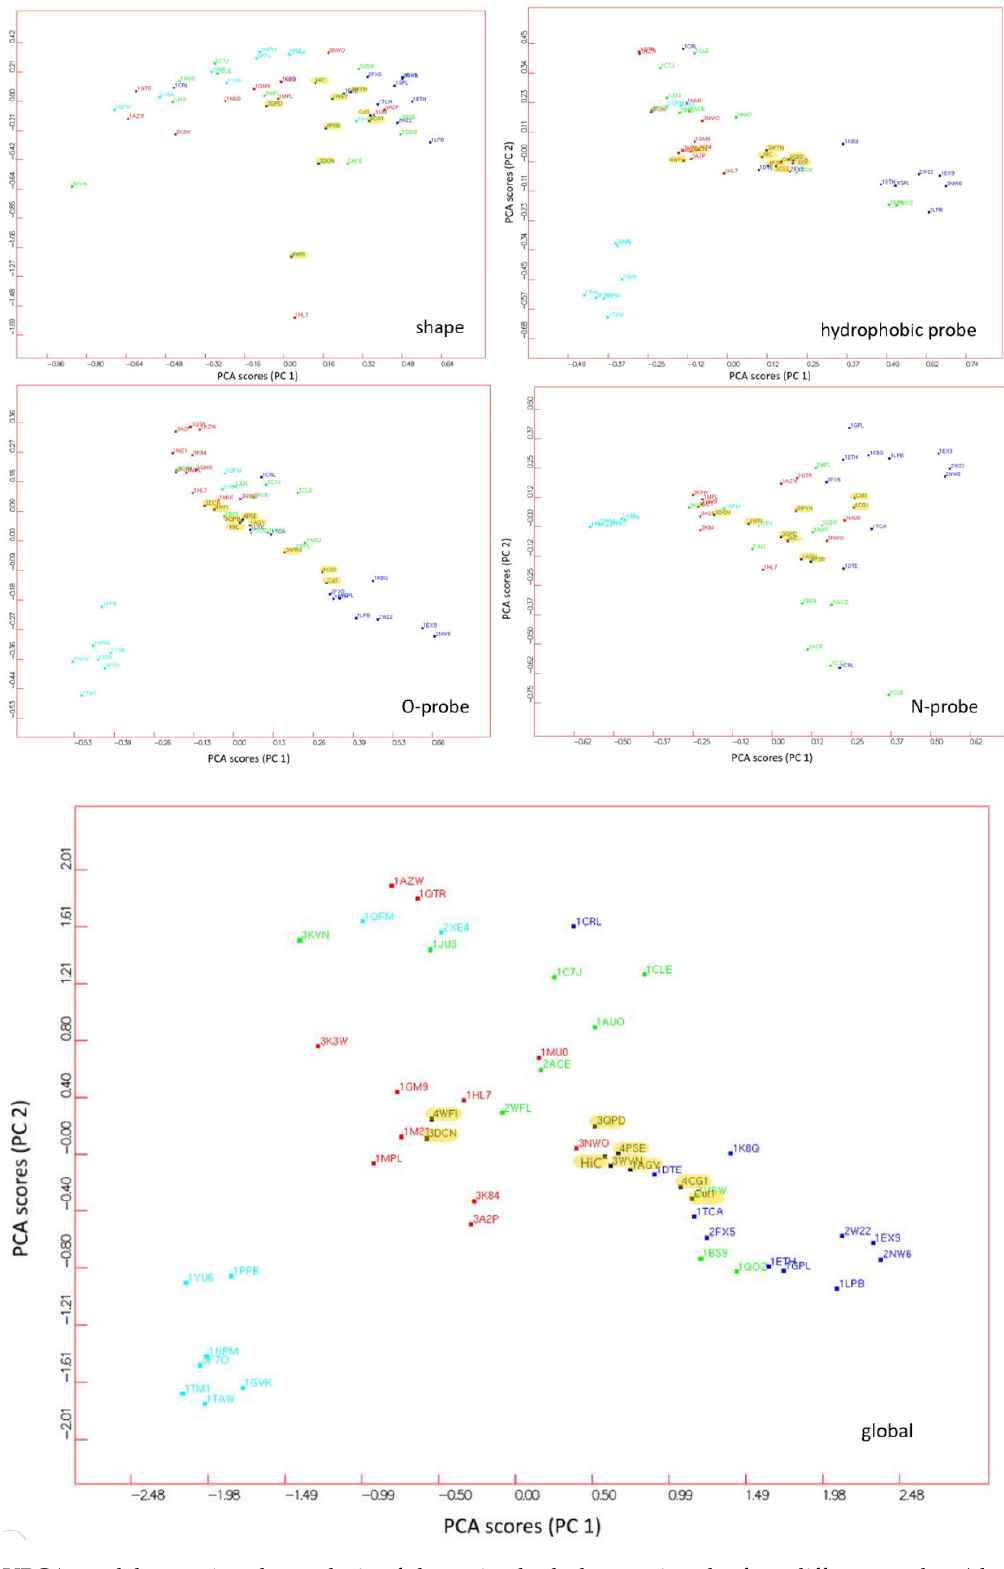
Figure 7. UPCA model reporting the analysis of the serine-hydrolases using the four different probes (shape probe, hydrophobic probeO- probe, N- probe) and the global score accounting for all the before mentioned probesColor code: lipases (blue), esterases (green), proteases (cyan), amidases (red) and cutinases (yellow). Individual panels can be found as full-page images in Supplementary Figures S4–S10.